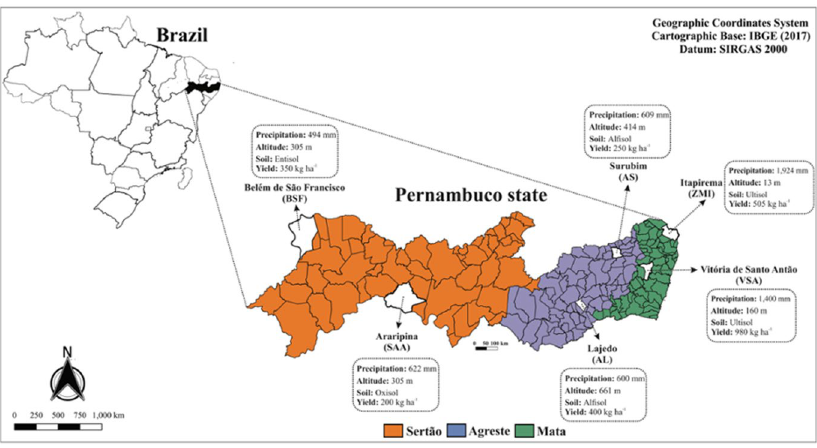
Figure 6. Geographic location of Pernambuco state, Brazil. Different colors mean the three studied ecoregions, i.e., Sertão, Agreste and Mata (including two localities in each). The map was created using QGIS software version 3.12.1 (https ://qgis.osgeo